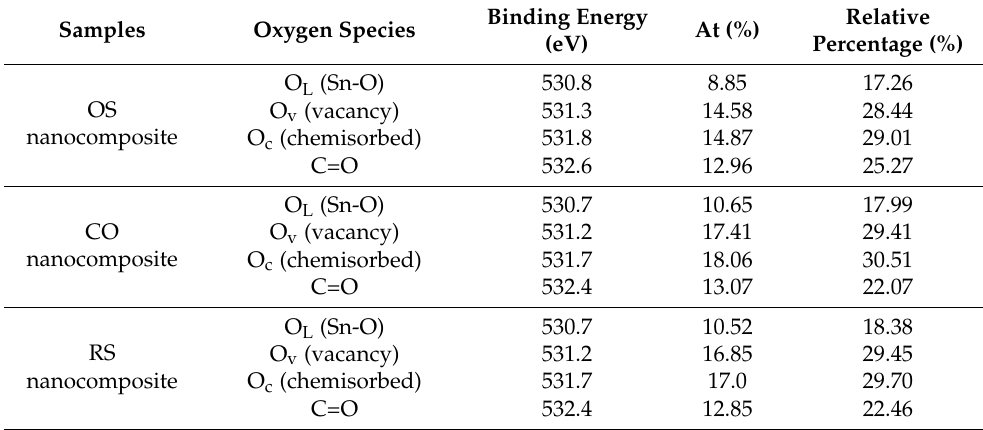
Table 3. The fitting results of O1s XPS spectrum of OS, CO, and RS nanocomposites.